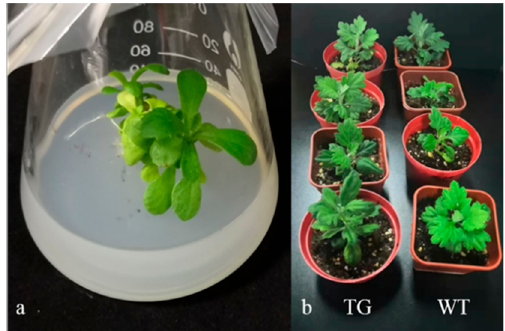
Figure 5. Positive CmTFL1a transgenic shoots of Chrysanthemum cultivar Jinba; ( a ) putative resistant shoot on rooting medium; ( b ) TG: Transgenic plants, WT: Wild type plants produced in a greenhouse.